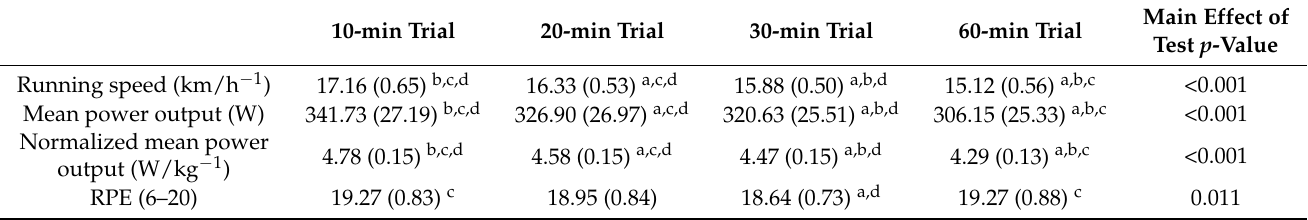
Table 2. Acute response (mean, SD) to the different running time trials.